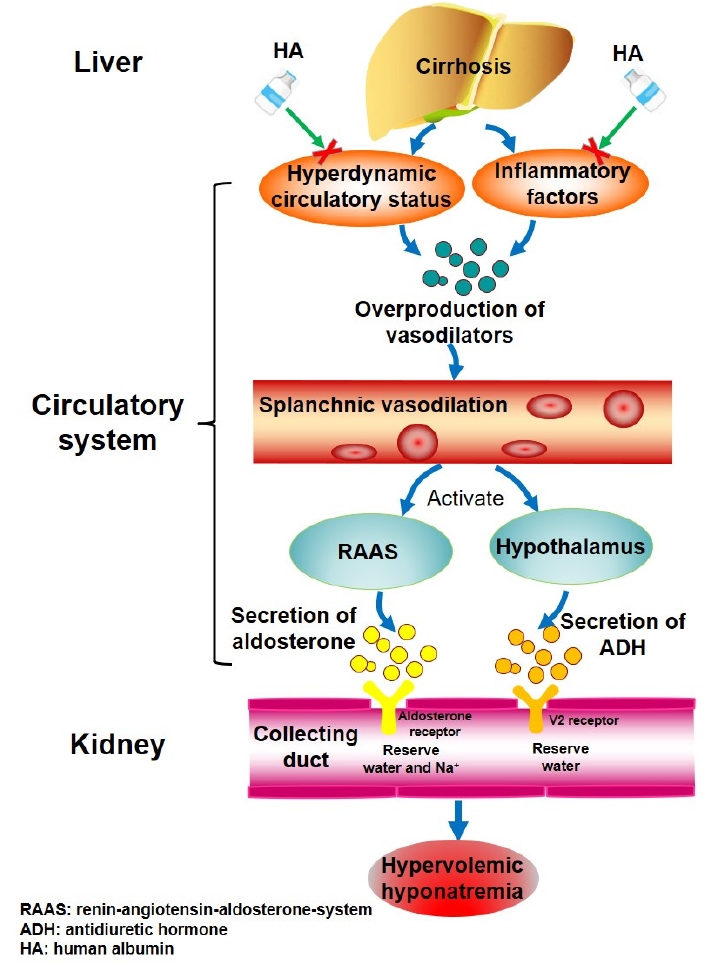
Figure 1. Potential mechanisms of human albumin infusion on hyponatremia.